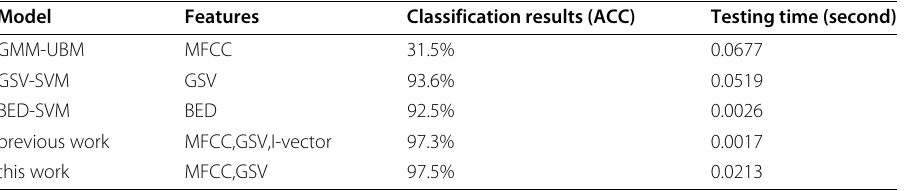
Table 9 Verification of effectiveness based on end-to-end